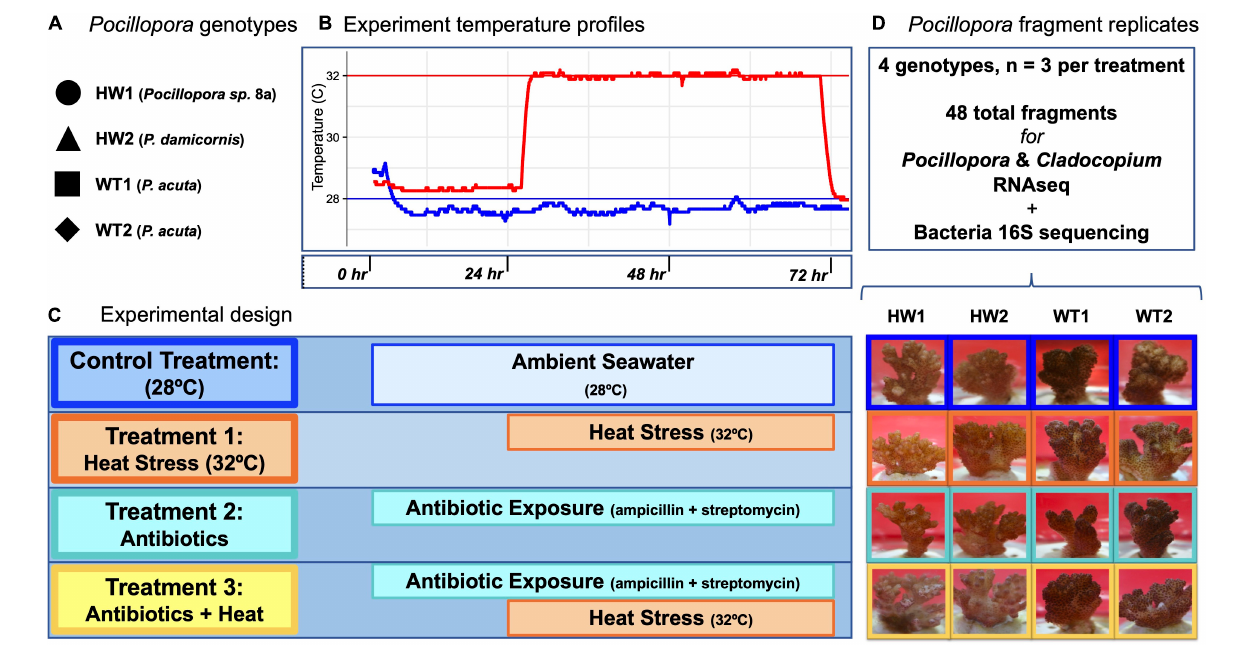
FIGURE 1 | Experimental design for heat stress, antibiotics, and antibiotics-heat stress treatments. (A) Pocillopora genotypes and species identifications used in the experiment. (B) Experiment temperature profiles for control (blue) and heat stress (red) aquarium systems. (C) Experimental design indicating the intensity and duration of the control, heat stress, antibiotics, and antibiotics-heat stress treatments. (D) Fragment replicates used for downstream sequencing analyses and representative photographs of Pocillopora coral fragments from each genotype in each treatment at the time of sampling. All fragments in the control, heat stress, and antibiotics treatment appeared visually healthy, while two fragments in the antibiotics-heat stress treatment showed early signs of tissue loss.